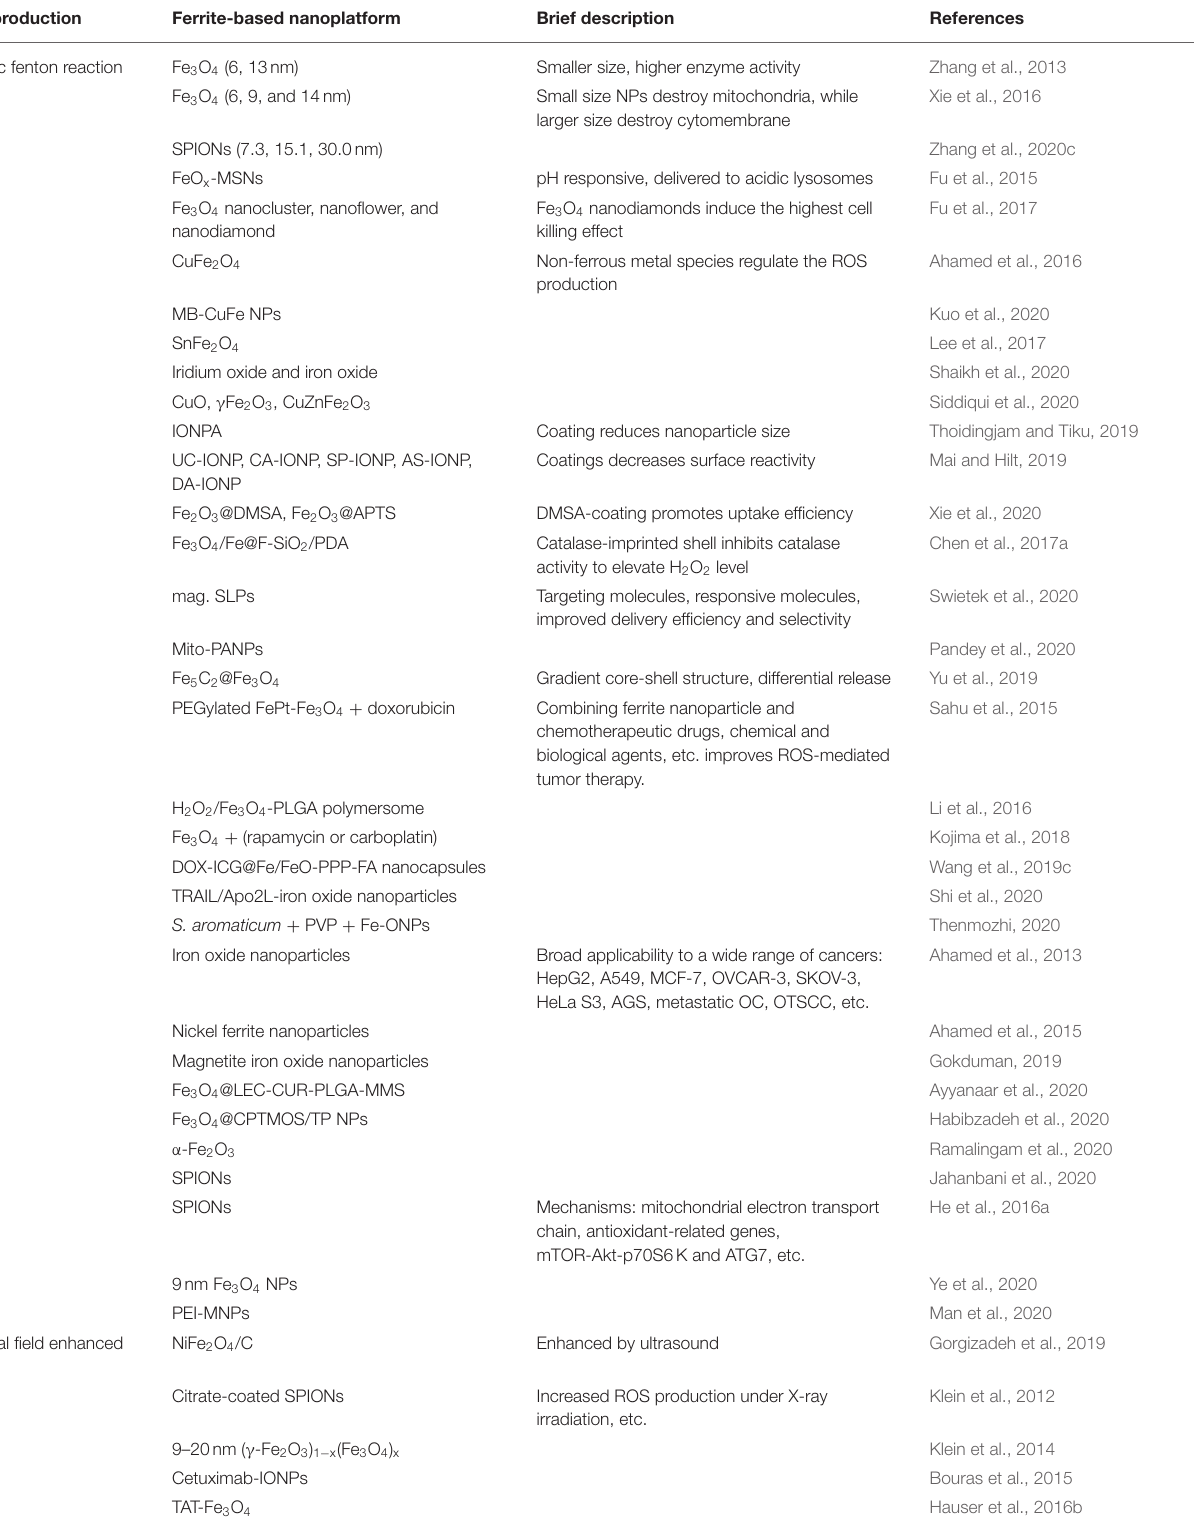
TABLE 1 | Summary of current ferrite nanoparticles used for ROS-mediated cancer therapy. ROS